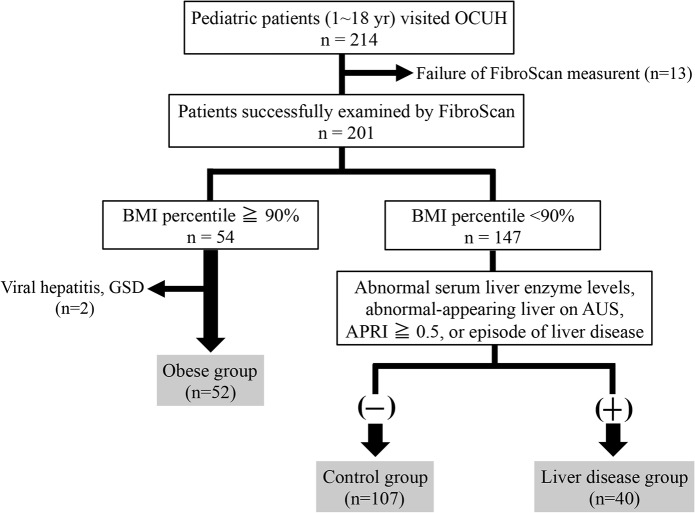
Diagram of the study population selection process.Patients who were examined by using FibroScan at a success rate of greater than 60% with 10 valid measurement and an interquartile range (IQR) of 30% or less than 30% of the median LSM value were analyzed for the study. Patients whose body mass index (BMI) was at the 90th percentile or higher and without underlying liver diseases were included in the obese group. Patients whose BMI was lower than the 90th percentile were divided into 2 groups: control group or liver disease group. The control group was defined as having normal serum liver enzyme levels, an aspartate aminotransferase (AST)-to-platelet ratio index (APRI) score below 0.5, a normal-appearing liver on abdominal ultrasonography, and no episodes of liver disease. The remaining patients were included in the liver disease group.